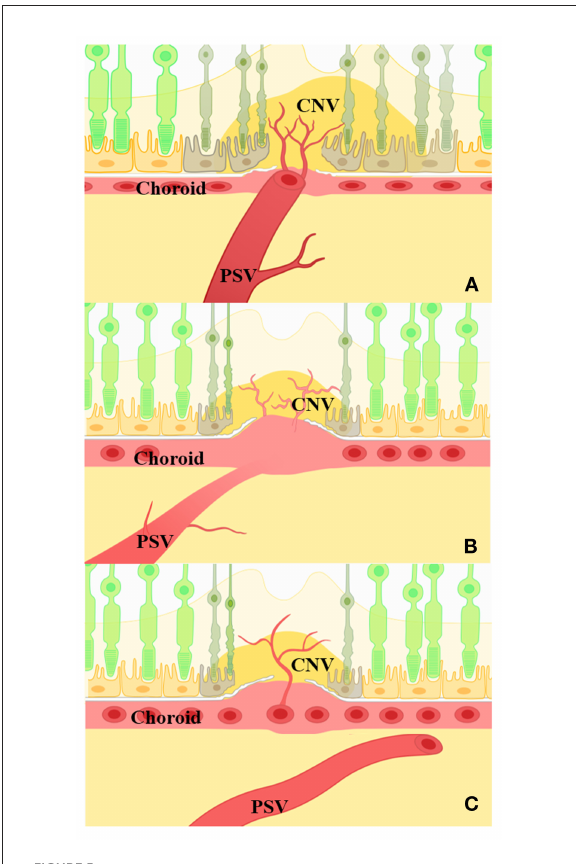
FIGURE5 Schematic drawing of the possible relationship between PSVs and mCNV. (A) PSVs adjacent to mCNV via a defective Bruch’s membrane. The choroid is thin or absent in this region. Photoreceptor and retinal pigment epithelium (RPE) cells were destroyed, and CNV may anastomose with PSVs. (B) PSVs penetrated into the dilated choroid; the dilated choroid was then adjacent to mCNV via a defective Bruch’s membrane. The enlarged vessel under CNV indicated a dilated choroidal structure, and CNV may arise from the defective Bruch’s membrane near the dilated choroidal vessels. (C) PSVs passed under mCNV. PSVs showed no significant correlation with the position of